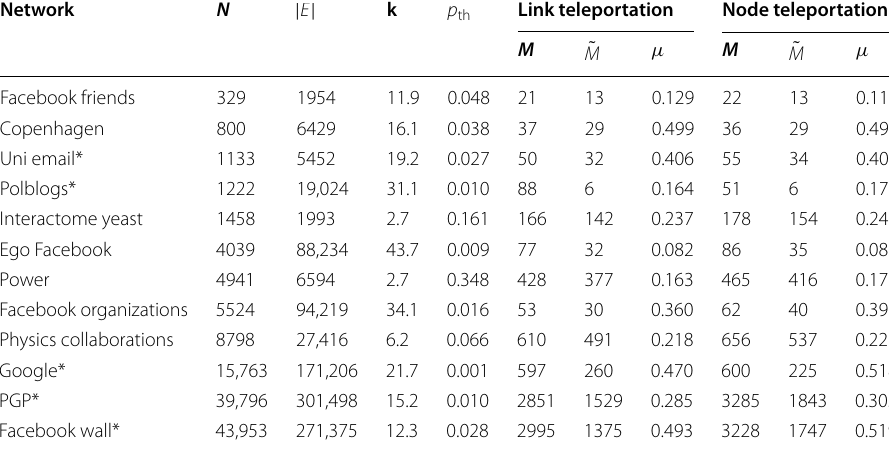
Directed networks are marked with